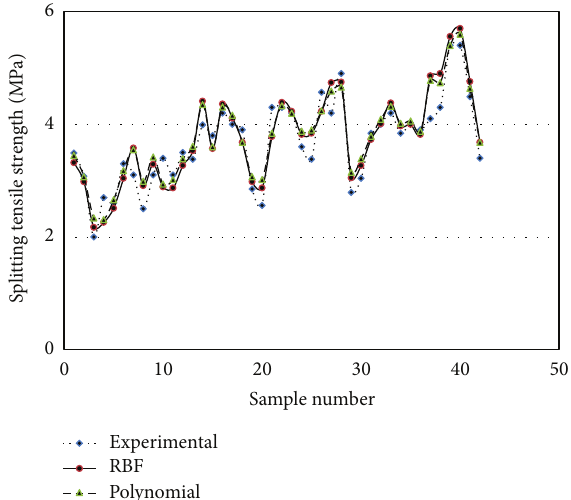
Figure 4: Comparison of experimental results to testing results of